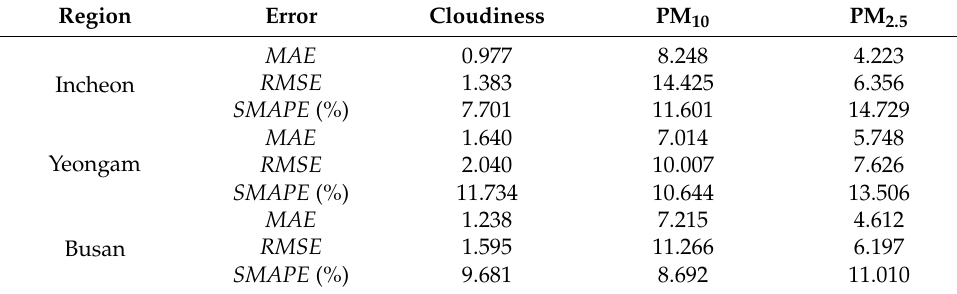
Table 11. The results of clouds and PM prediction.